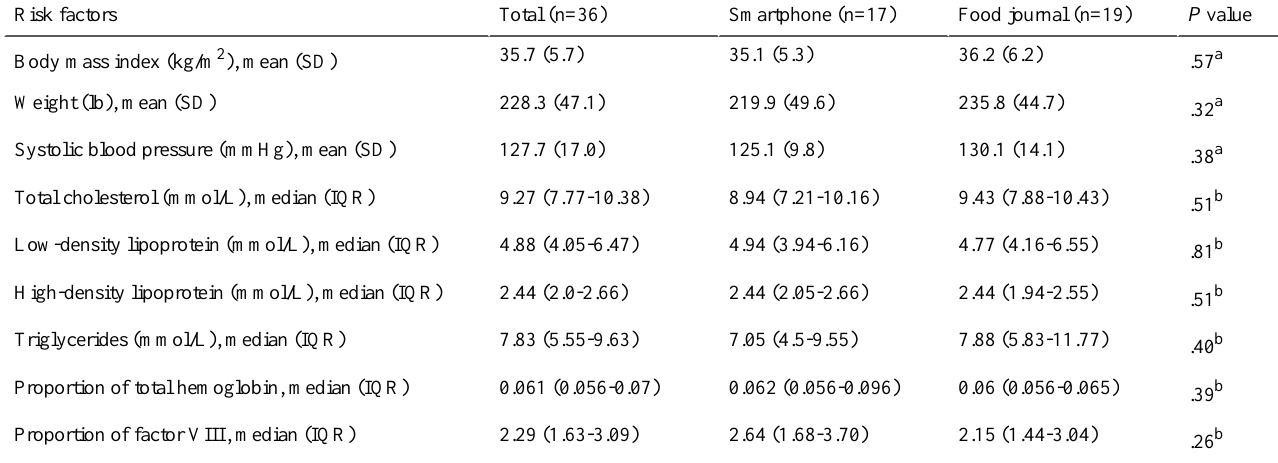
Table 2. Objective cerebrovascular risk